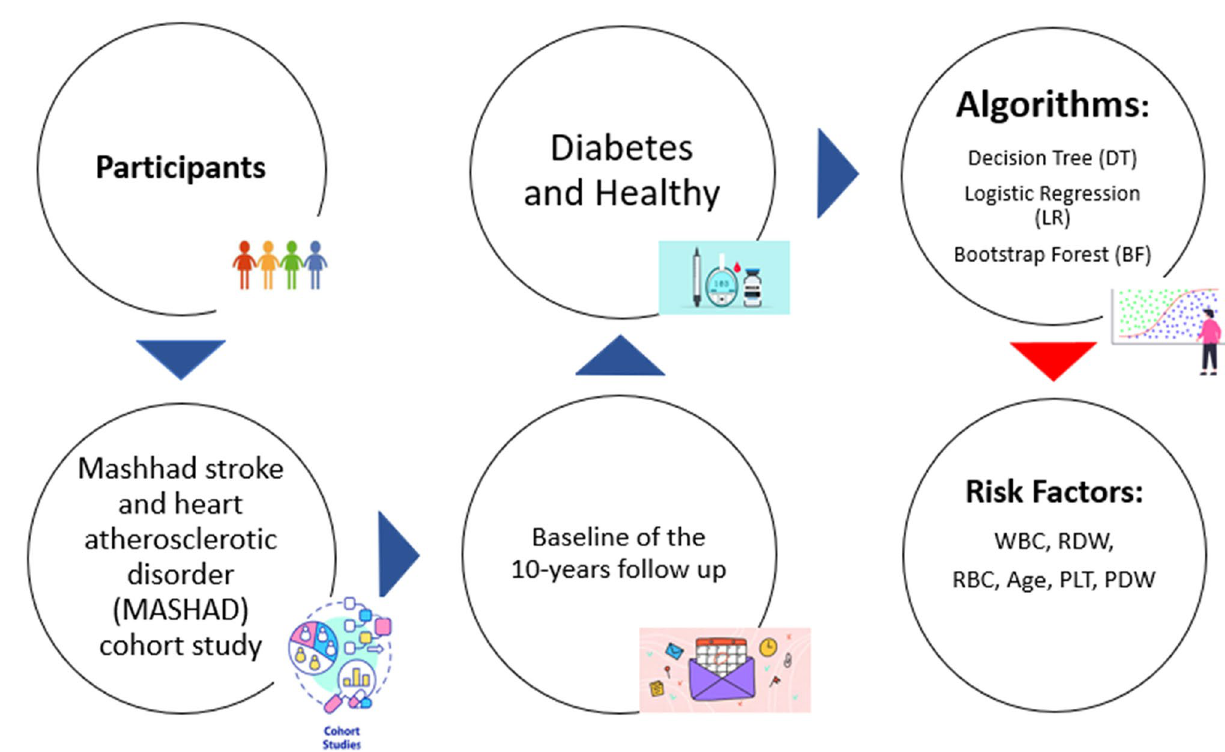
Figure 3. Graphical